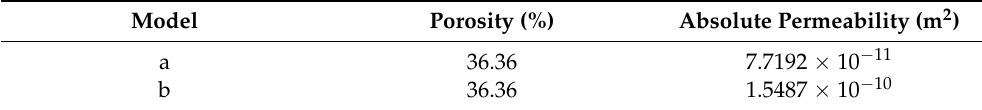
Table 5. Porosity and absolute permeability